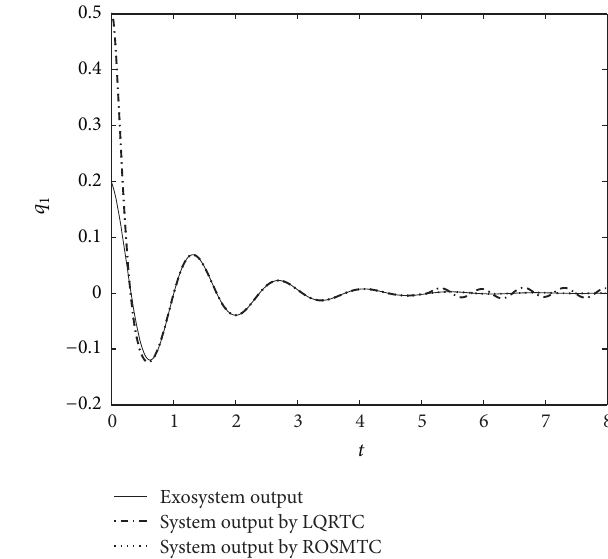
Figure 4: The tracking error 𝑒 3 (𝑡) of position 𝑞 2 for link 2.